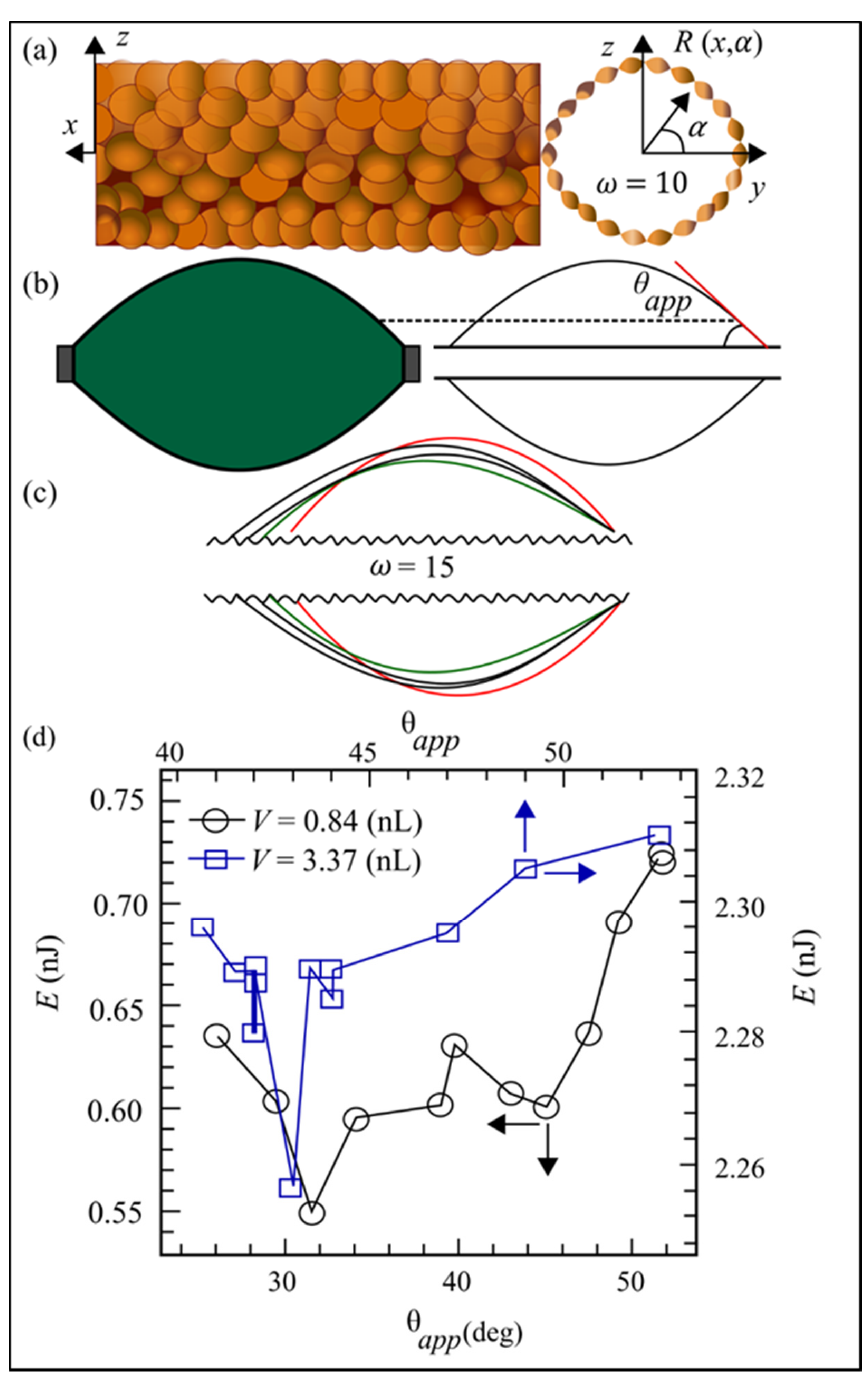
Figure 1. Our simulated crude fibers are displayed through side and cross-sectional views ( a ). The point of inflection and apparent contact angle are depicted in ( b ). In ( c ) the volume V = 0.84 nL on rough fibers with rf = 15 µ m, θ YL = 30 and x = 15. In ( d ), the surface energy of droplets is plotted against apparent contact angle for droplet volumes of V = 0.84 nL (black symbols) and V = 3.37 nL (blue symbols) [59].